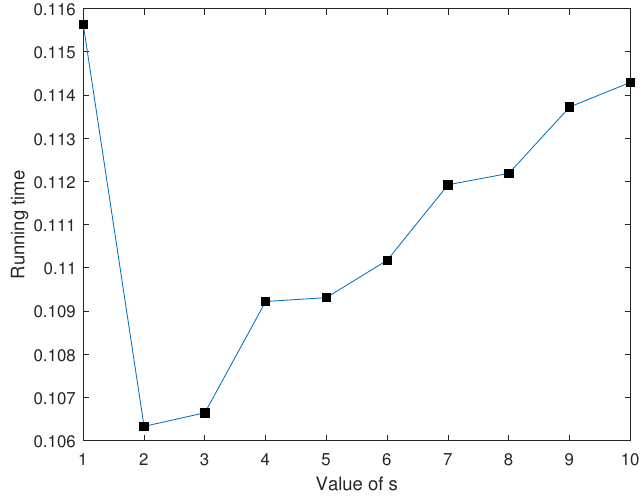
Figure 6. Running time with noisy data after 100